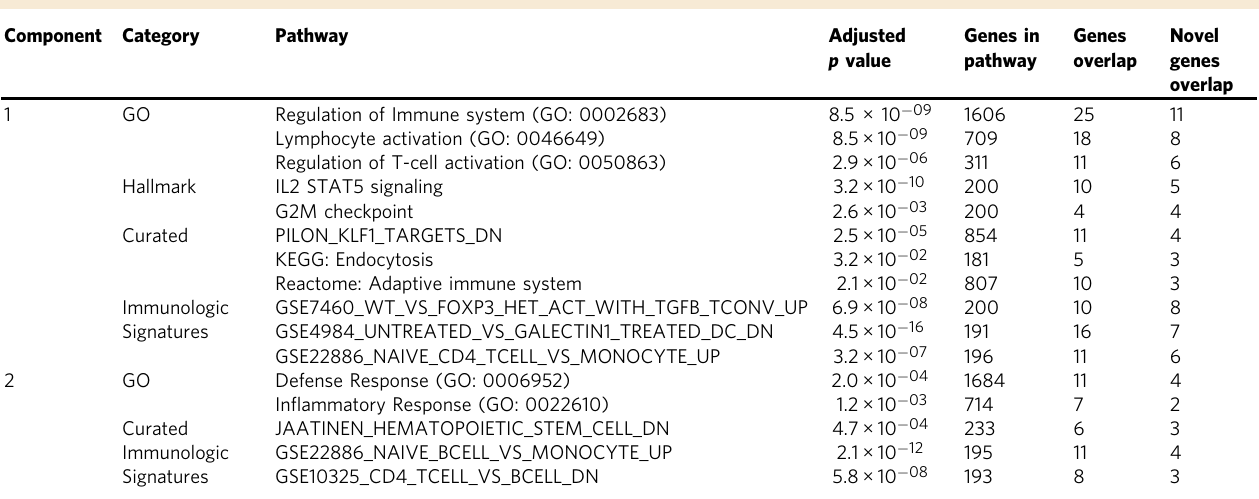
Table 4 Pathway enrichment results for the target genes selected for UC. Component